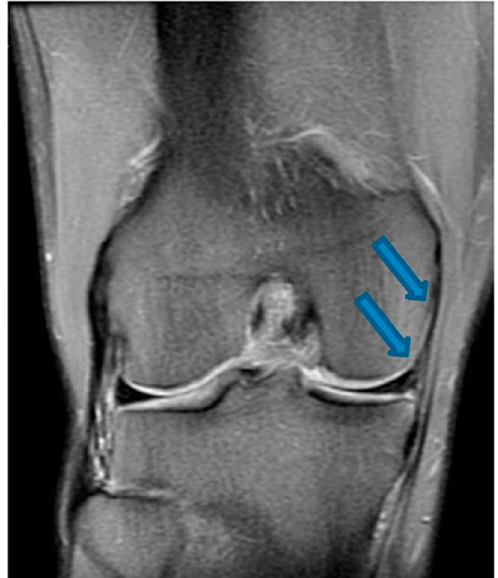
Figure 3. Sagittal T1- and T2-weighted MRI of the knee confirming complete healing of the ACL indicated by blue arrows (24 December 2021).